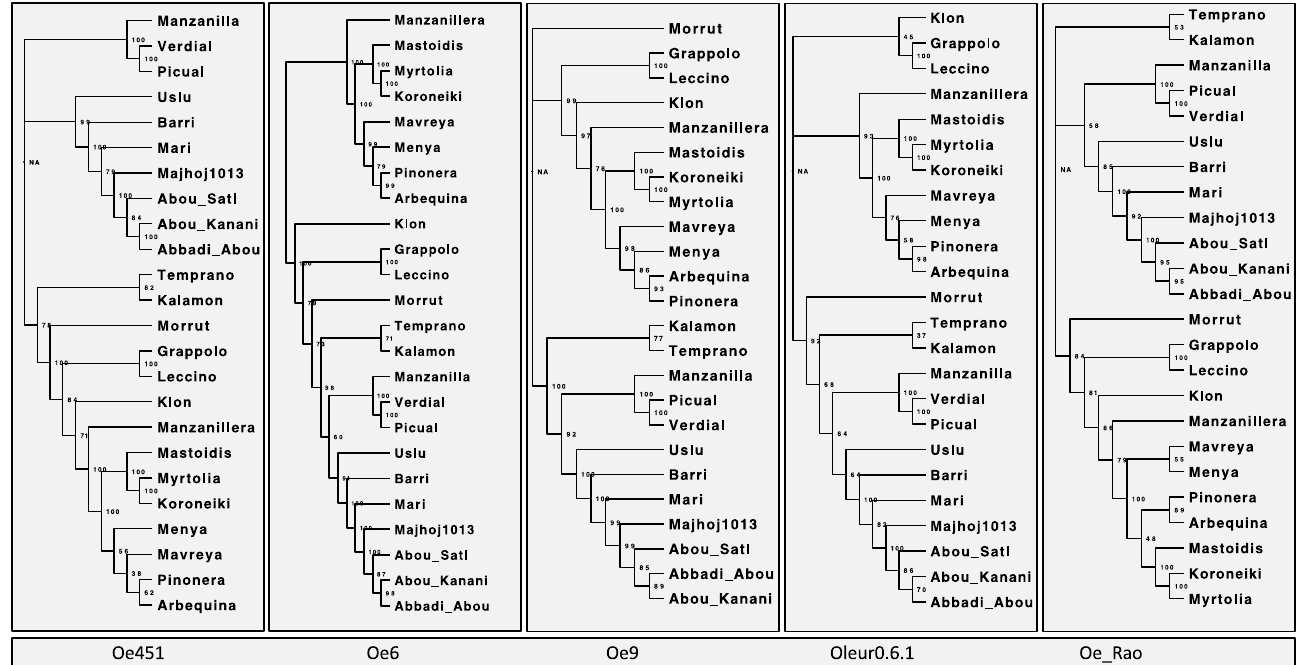
Figure 1. Neighbour-joining trees constructed using GBS data. Comparison of the neighbour-joining (NJ) trees constructed from SNPs called using GBS data mapped to each of the reference genomes. Using the R package Poppr, the genetic distance between each sample using Provesti’s distance and NJ trees is plotted with a bootstrapping support of 100. The genome used to generate each is labelled above the corresponding tree.